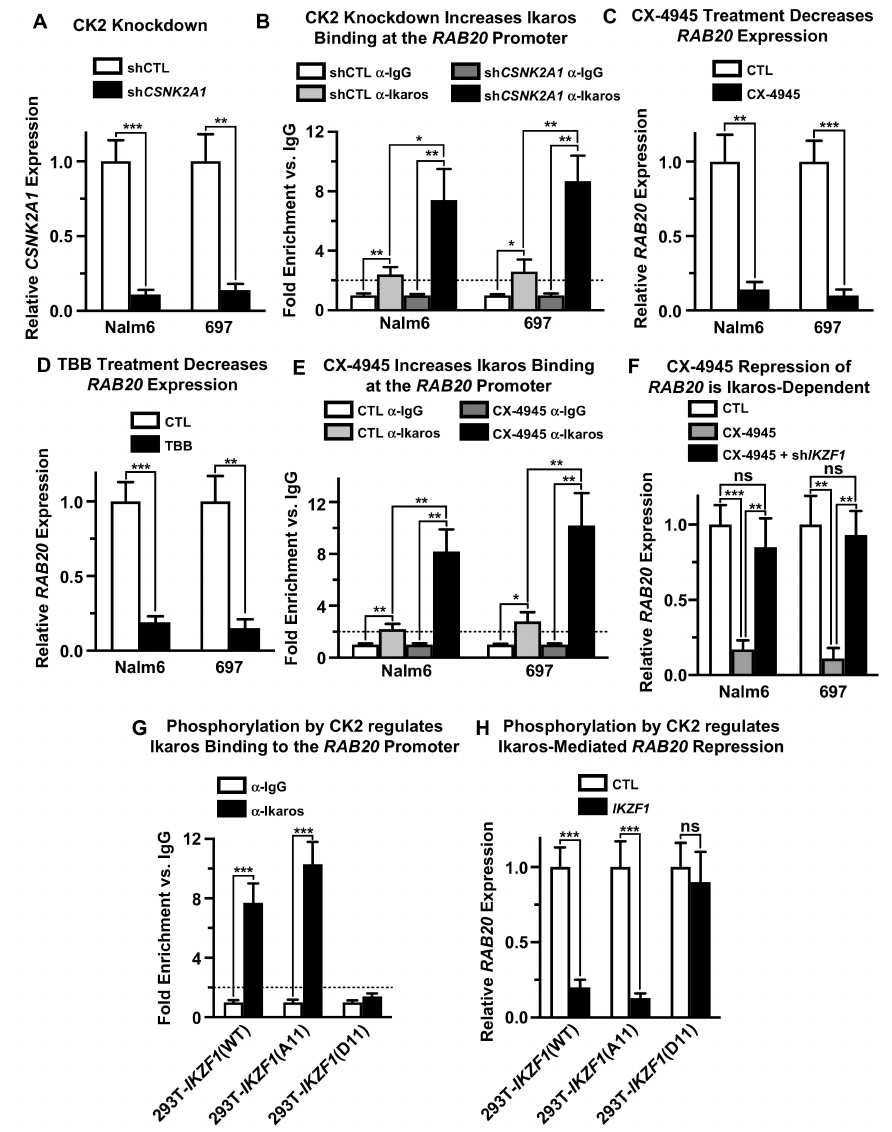
Figure 4. CK2 regulates Ikaros’ ability to repress RAB20 transcription. ( A ) Human B-ALL cell lines were transduced with scrambled shRNA (shCTL) and shRNA targeting CK2 α (sh CSNK2A1 ) and relative CSNK2A1 expression was determined using qRT-PCR. ( B ) qChIP was used to analyze Ikaros occupancy at the RAB20 promoter after CK2 α knockdown (sh CSNK2A1 ). ( C,D ) Human B-ALL cell lines were treated with pharmacological CK2 inhibitors CX-4945 and TBB, and RAB20 expression was analyzed using qRT-PCR. ( E ) qChIP was used to analyze Ikaros occupancy at the RAB20 promoter after treatment with CX-4945. ( F ) Human B-ALL cell lines were treated with CK2 inhibitor CX-4945 and transduced with shRNA targeting Ikaros (sh IKZF1 ) and RAB20 expression was analyzed by qRT-PCR. ( G ) HEK293T cells were transduced with wild-type Ikaros ( IKZF1 -(WT)), Ikaros with phosphoresistant alanine mutations at CK2 phosphosites ( IKZF1 -(A11)), and Ikaros with phosphomimetic aspartate mutations at CK2 phosphosites ( IKZF1 -(D11)). qChIP was used to determine Ikaros occupancy at the RAB20 promoter. ( H ) qRT-PCR was used to determine RAB20 expression in HEK293T cells transduced with wild-type Ikaros ( IKZF1 -(WT)) and Ikaros phosphoresistant IKZF1 -(A11) and phosphomimetic IKZF1 -(D11) mutants at CK2 phosphosites. The graphed data are the mean ± SD (error bars) from three independent